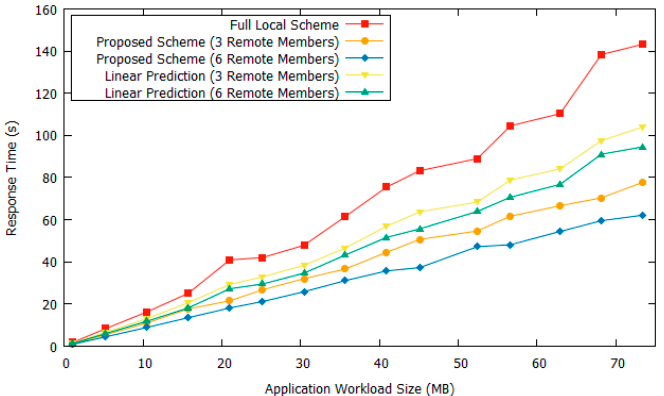
Figure 5. Response time comparison with 80 GHz bandwidth.